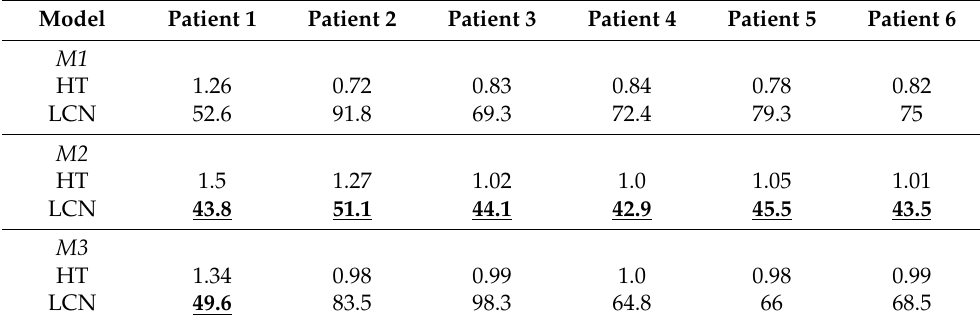
Table 1. Hepatocyte turnover (HT) and (%) Lowest liver cell number (LCN) under models M1 , M2 and M3 . Here, LCN represents the lowest liver cell number during the process of infection clearance as a fraction of H . The critical LCN threshold to maintain liver integrity is 52%. Bold and underlined numbers represents the case of liver-destruction and/or loss of liver